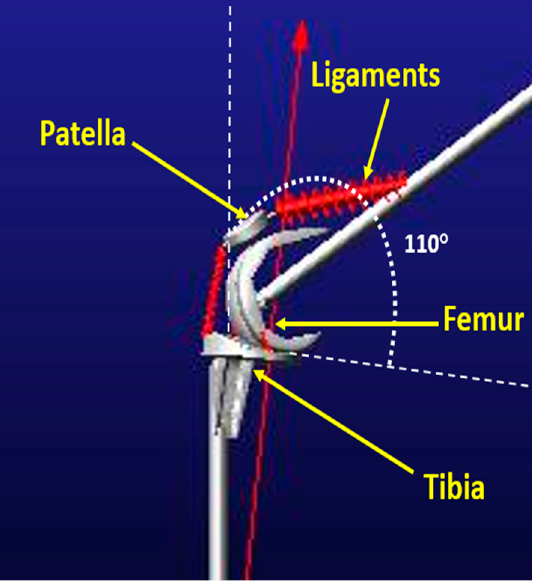
Figure 14. Multibody model at the position 100°.